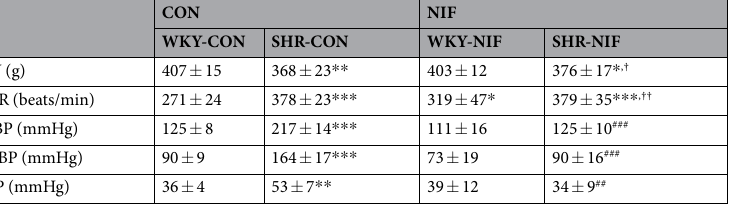
Table 1. Characteristics of the blood pressure in SHRs and WKYs. Values are presented as the mean ± SD. (n = 6). * P < 0.05, ** P < 0.01, *** P < 0.001, vs WKY-CON. ## P < 0.01, ### P < 0.001, vs SHR-CON. † P < 0.05, †† P < 0.01, vs WKY-NIF. W, weight; HR, heart rates; SBP, systolic blood pressure; DBP, diastolic blood pressure; PP, pulse pressure; CON, control; NIF, nifedipine.